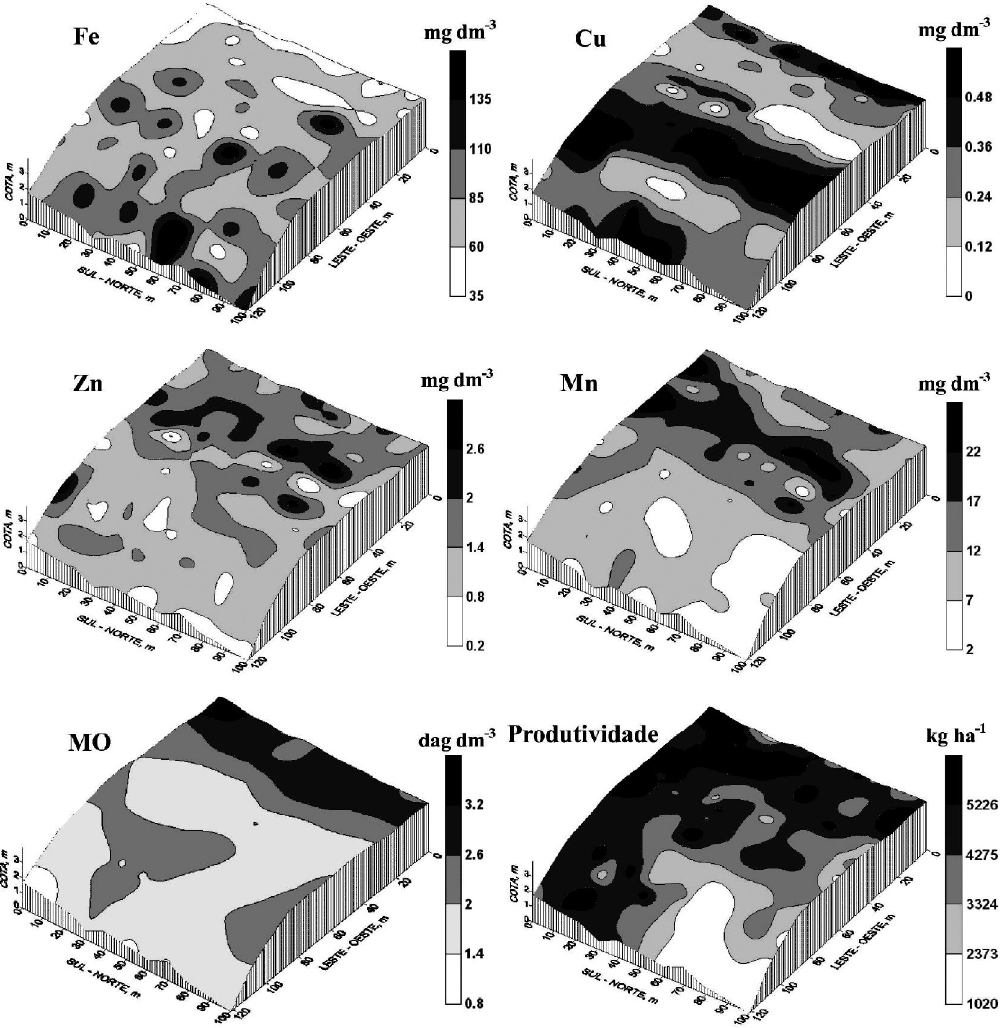
Figura 3. Mapas de distribuição espacial das variáveis ferro, cobre, zinco, manganês, matéria orgânica e produtividade da pimenta-do-reino, representados conjuntamente com o relevo da